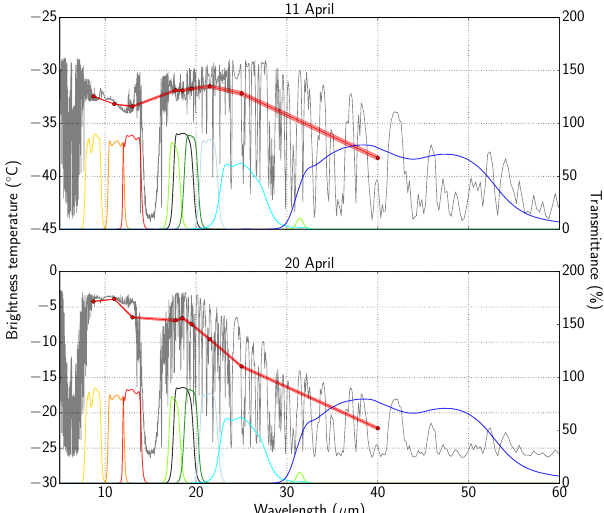
Figure 9. High spectral resolution brightness temperatures simu- lated with MODTRAN for the 11 and 20 April flights at 6km al- titude. FIRR filters transmittances are also shown, as well as the simulated FIRR spectral signatures. The red shaded areas indicate the uncertainties in the simulations due to uncertainties on the mea- sured temperature and relative humidity